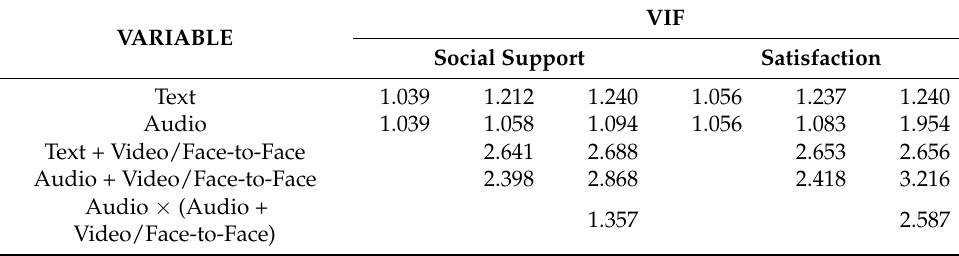
Table 13. Multicollinearity test—perceived social support and satisfaction.